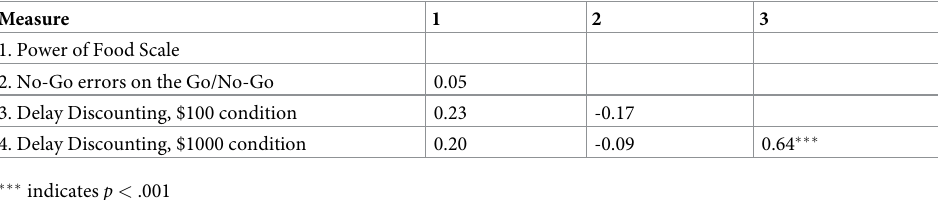
Table 1. Correlations between baseline power of food scale scores, No-Go errors on the Go/No-Go task, and delay discounting scores.